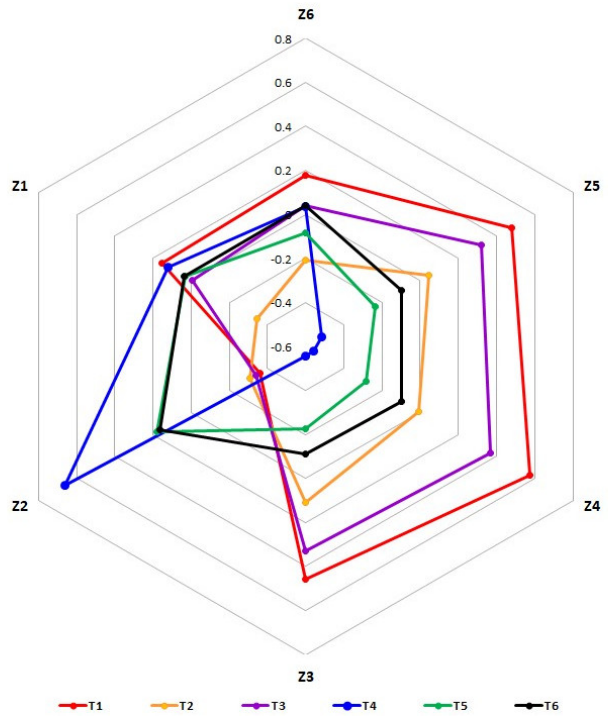
Figure 2. Comparison of distance covered in speed zones within different match timing zones. Note: Z1: 0–0.7 km.h −1 ; Z2: 0.7–7.2 km.h −1 ; Z3: 7.2–14.4 km.h −1 ; Z4: 14.4–19.8 km.h −1 ; Z5: 19.8–25.2 km.h −1 ;